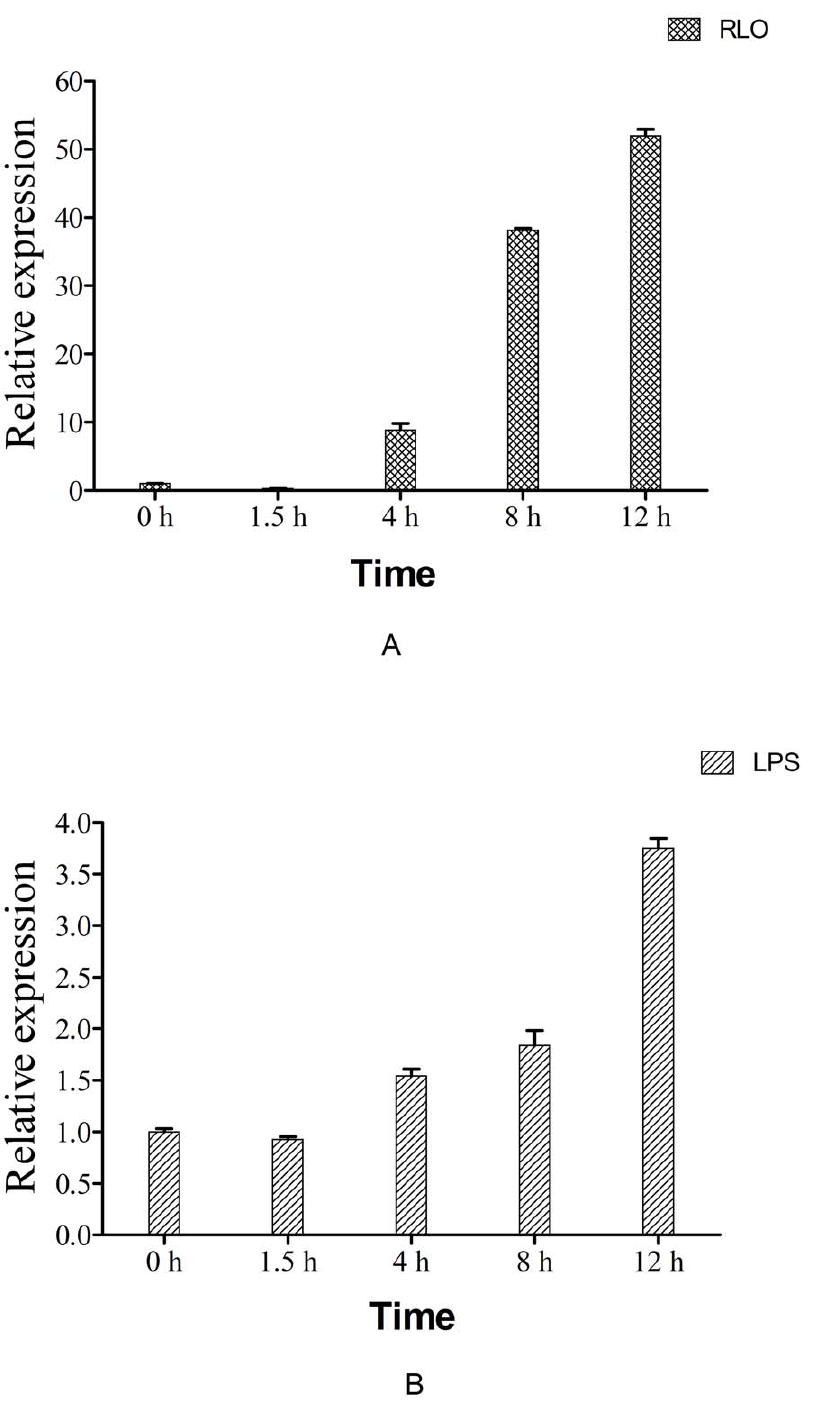
Figure 5. mRNA expression levels of Ca-HMGB in hemocyte monolayers at different times after RLO/LPS incubation. Samples were collected at 0, 1.5, 4, 8 and 12 h after RLO/LPS incubation. Expression levels were determined by real-time RT-PCR. The seawater-incubated groups were used as controls. Expression levels were assessed using 28SrDNA gene for normalization. *p # 0.05 when compared to control value. (A) RLO(1ul/ 10 6 cells) incubation; (B) LPS (100